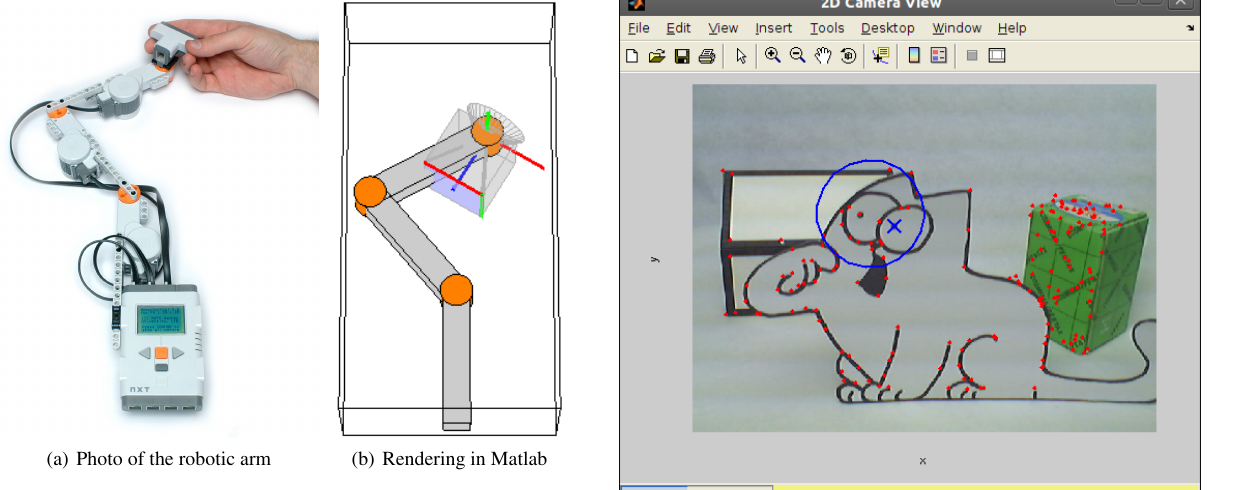
Figure 5: Photo (left) and rendering (right) of the robotic arm. Rotation angles of the three orange sensors are transferred via the control unit at the bottom to the Matlab implementation of our tracking and reconstruction framework. The pose of the virtual camera at the end of the arm is computed from the three angles and can be used as ground truth camera orientation. Image points are then generated by projecting a virtual scene point cloud into the virtual camera and adding Gaussian noise.